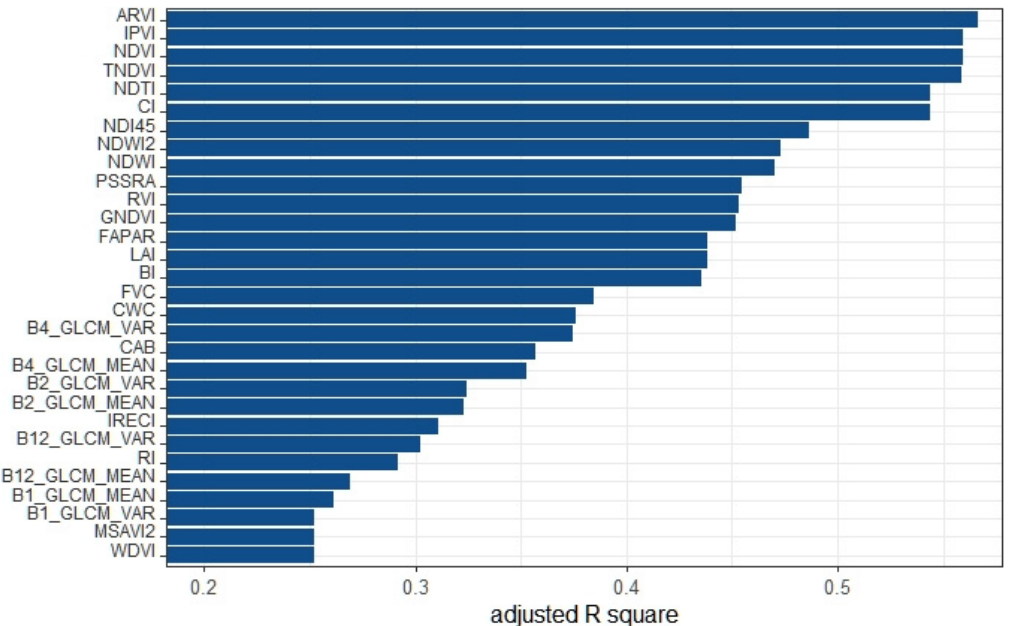
Figure 4. The adjusted coefficient of determination of the 30 most dominant predictors (indices) using simple linear ordinary least squares (OLS) regression. Table 3. The results of 10-fold cross-validation (CV) on the training set using a single S-2 image. RMSE, root-mean-square error; MAE, mean absolute